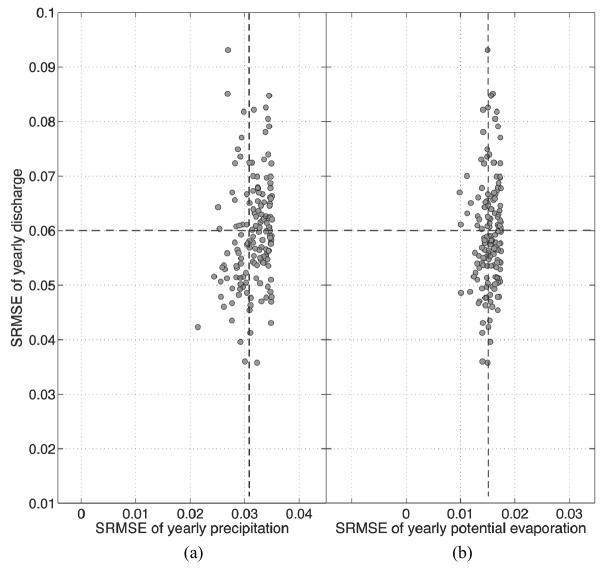
Figure 5. 4 Fig. 5. SRMSE values of yearly precipitation (a) and potential evap- SRMSE values of yearly precipitation (a) and potential evaporation (b) plotted against 5 oration (b) plotted against SRMSE values of yearly discharge, for SRMSE values of yearly discharge, for 196 realisations of selected source cells with 6 discharge SRMSE values less than 0.1. Dashed lines indicate mean values. 7 196 realisations of selected source cells with discharge SRMSE val- ues less than 0.1. Dashed lines indicate mean